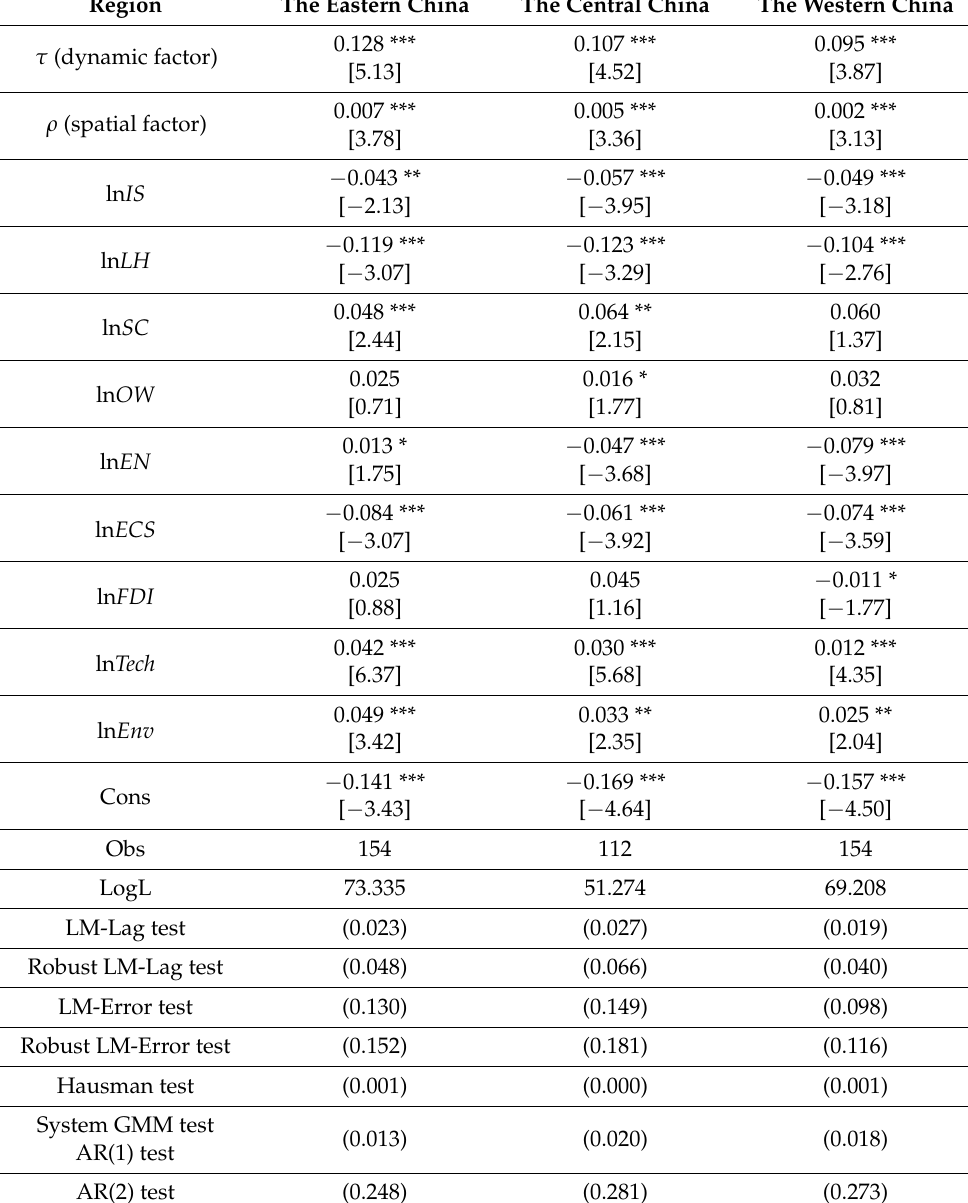
Table 6. Estimation results at the regional